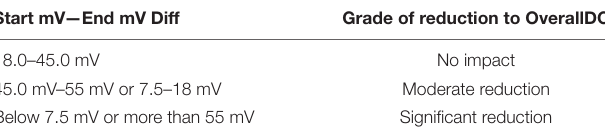
TABLE 1 | Simplified curve change mV reduction